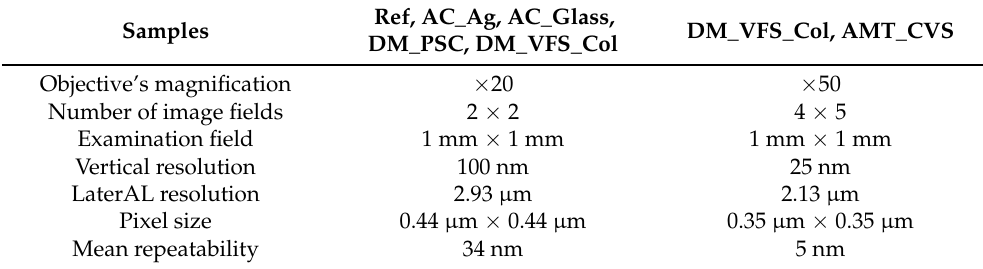
Table 2. Measurement parameters of the surface topography on the focus variation